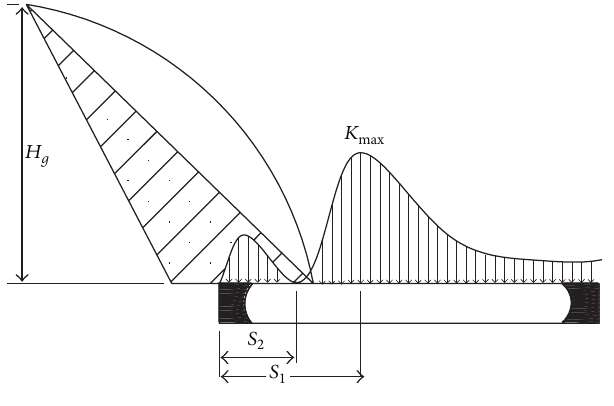
Figure 6: Pressure bearing model.